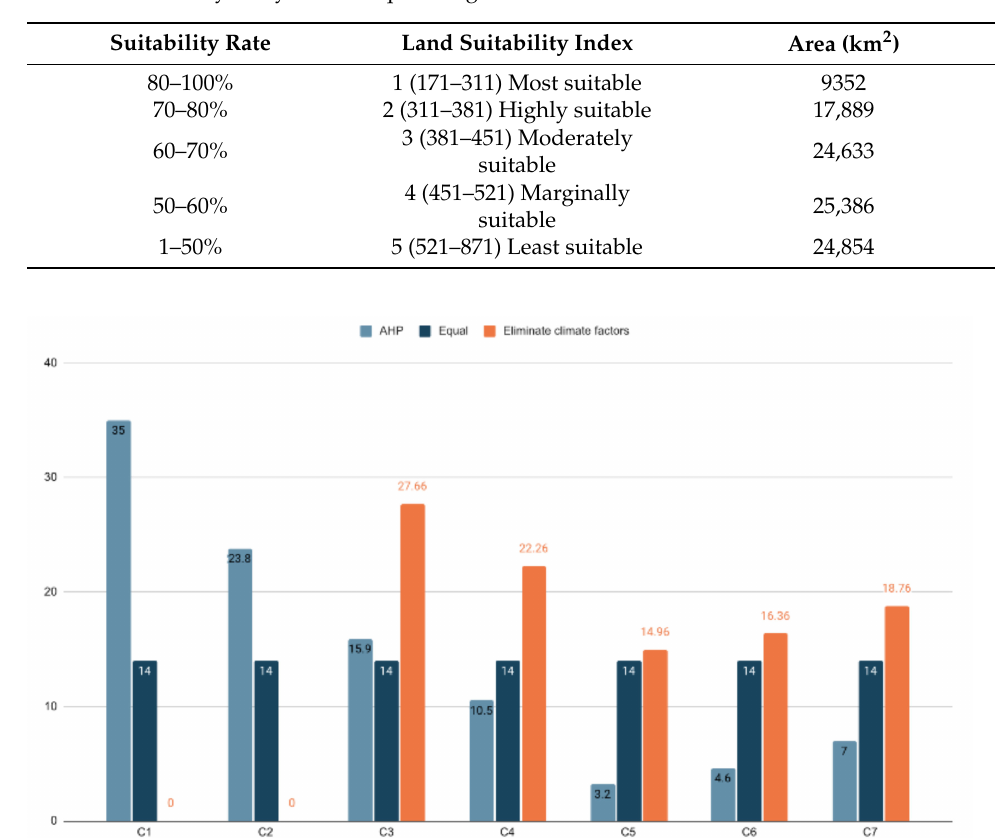
Table 13. Sensitivity analysis with equal weights.